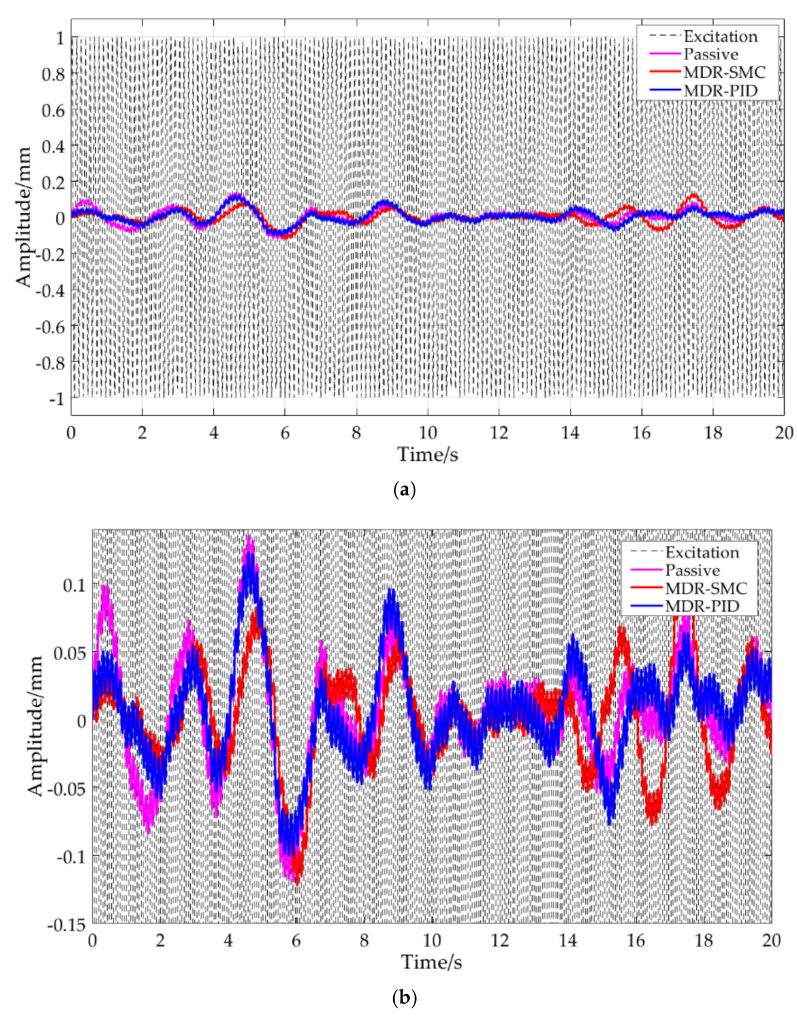
Figure 22. Comparison of the SMC with MRD, PID with MRD, and the passive system under excitation of a sinusoidal signal with an amplitude of 1 mm and a frequency of 50 rad/s: ( a ) full figure; ( b ) partial enlarged